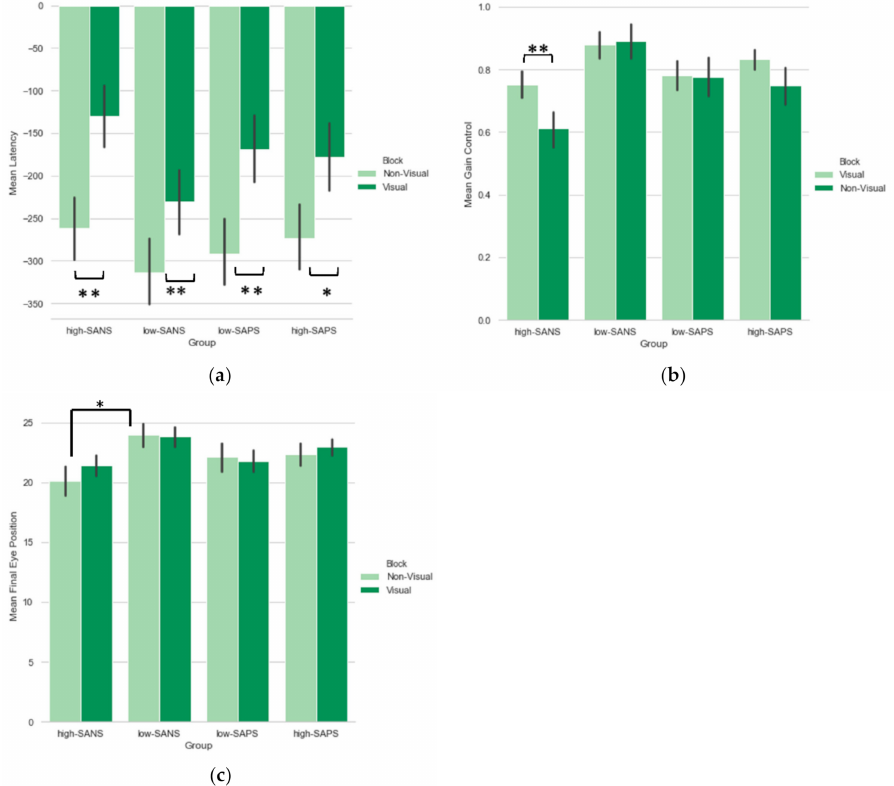
Figure 2. A comparison of performance between the two blocks within each group in the ( a ) latency, ( b ) gain control, and ( c ) final eye position, measure. Error bars refer to standard error. * indicates significance to the p < 0.05; ** indicates significance to p <